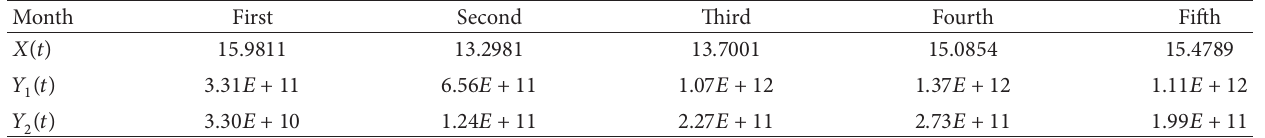
Table 8: The input and outputs center of gravity for DMU 7